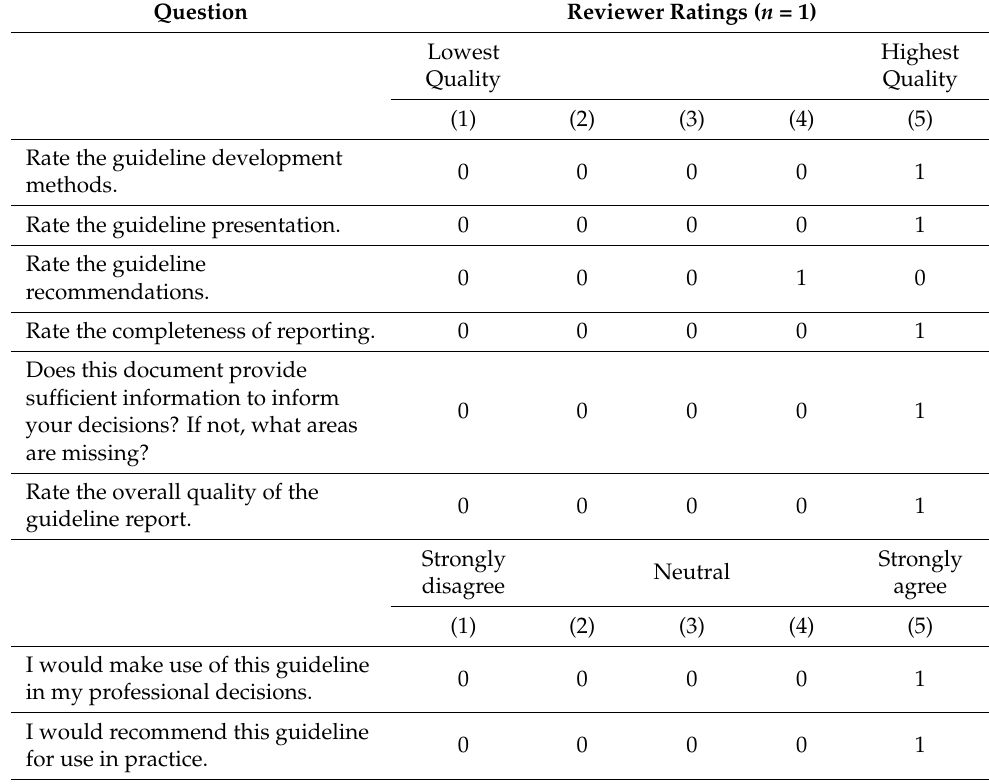
Table 1. Responses to nine items on the targeted peer reviewer